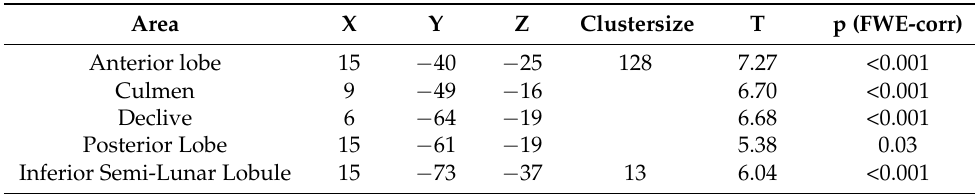
Table 2. Right cerebellar areas showing significantly more activation during tapping than during stroking.